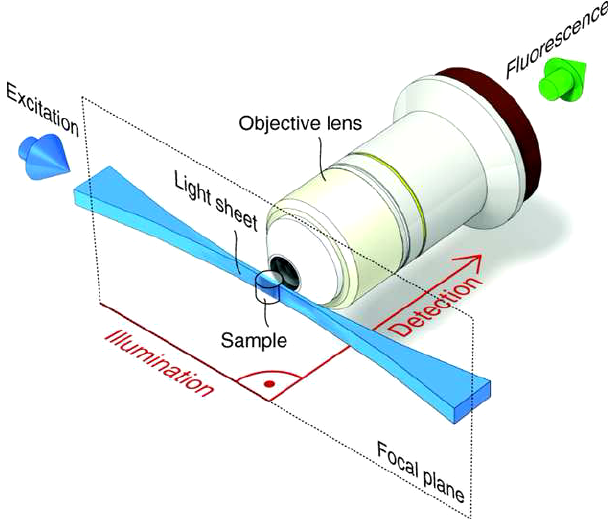
Fig. 1. Simpli¯ed scheme of a light sheet illumination micro- scope. The light sheet lies in the focal plane of the detection objective. Fluorescence andexcitationlight are indicated in green and blue, respectively. Reproduced with permission from Ref.